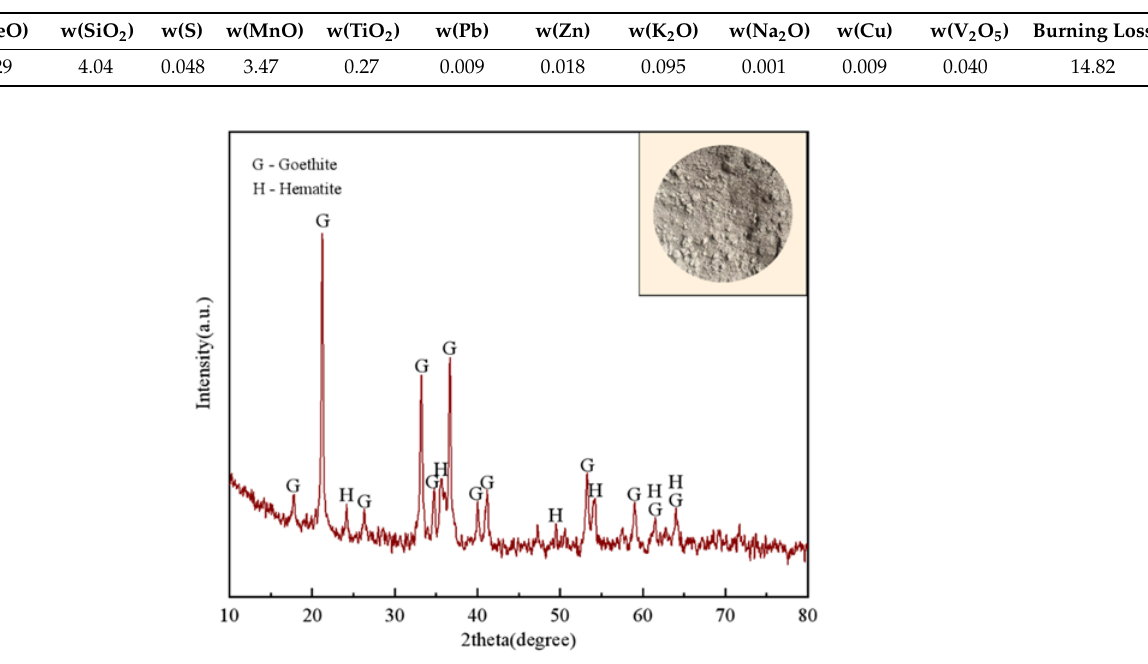
Figure 3. SEM of Guisha limonite: ( a ) 150×, ( b ) 2000×, ( c ) 5000×, ( d )10,000×. Table 2. Iron ore chemical composition.